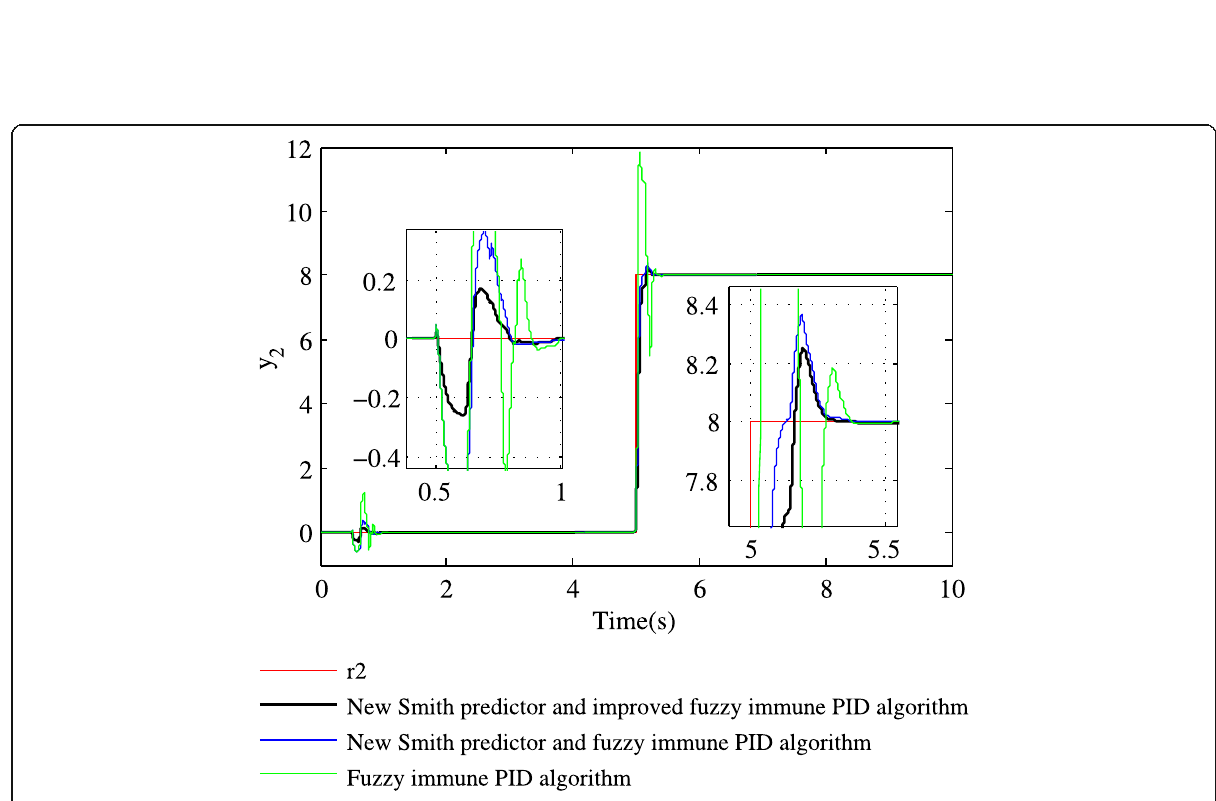
Fig. 10 The step responses of loop 2 when the model matches the generalized